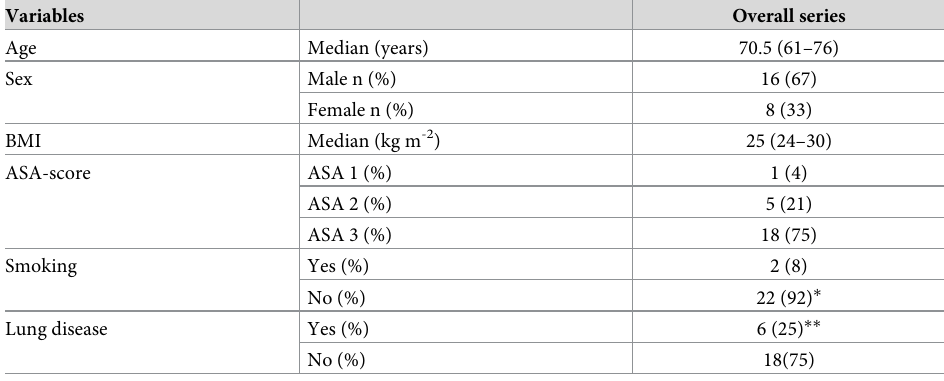
Table 1. Patient characteristics presented as mean (SD) or median (IQR) as